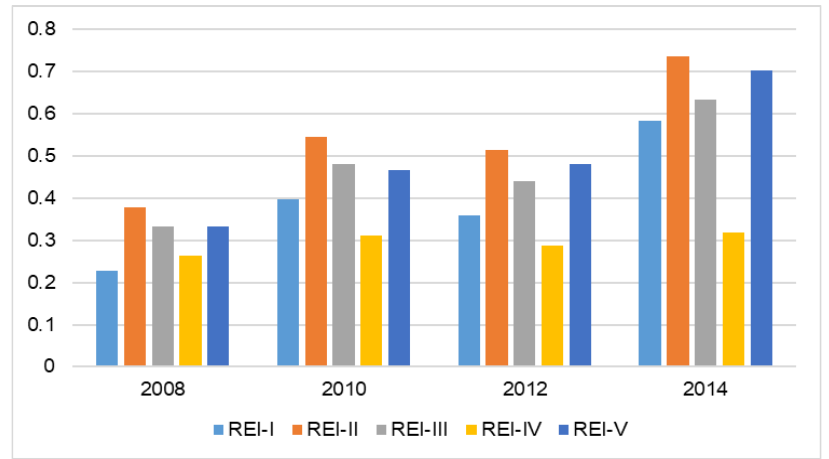
Fig. 6. Residential energy price indices, 2008–2014 (FAO, n. d.; INEGI 2015a, Mexican Geological Service, 2017; SENER, 2016).